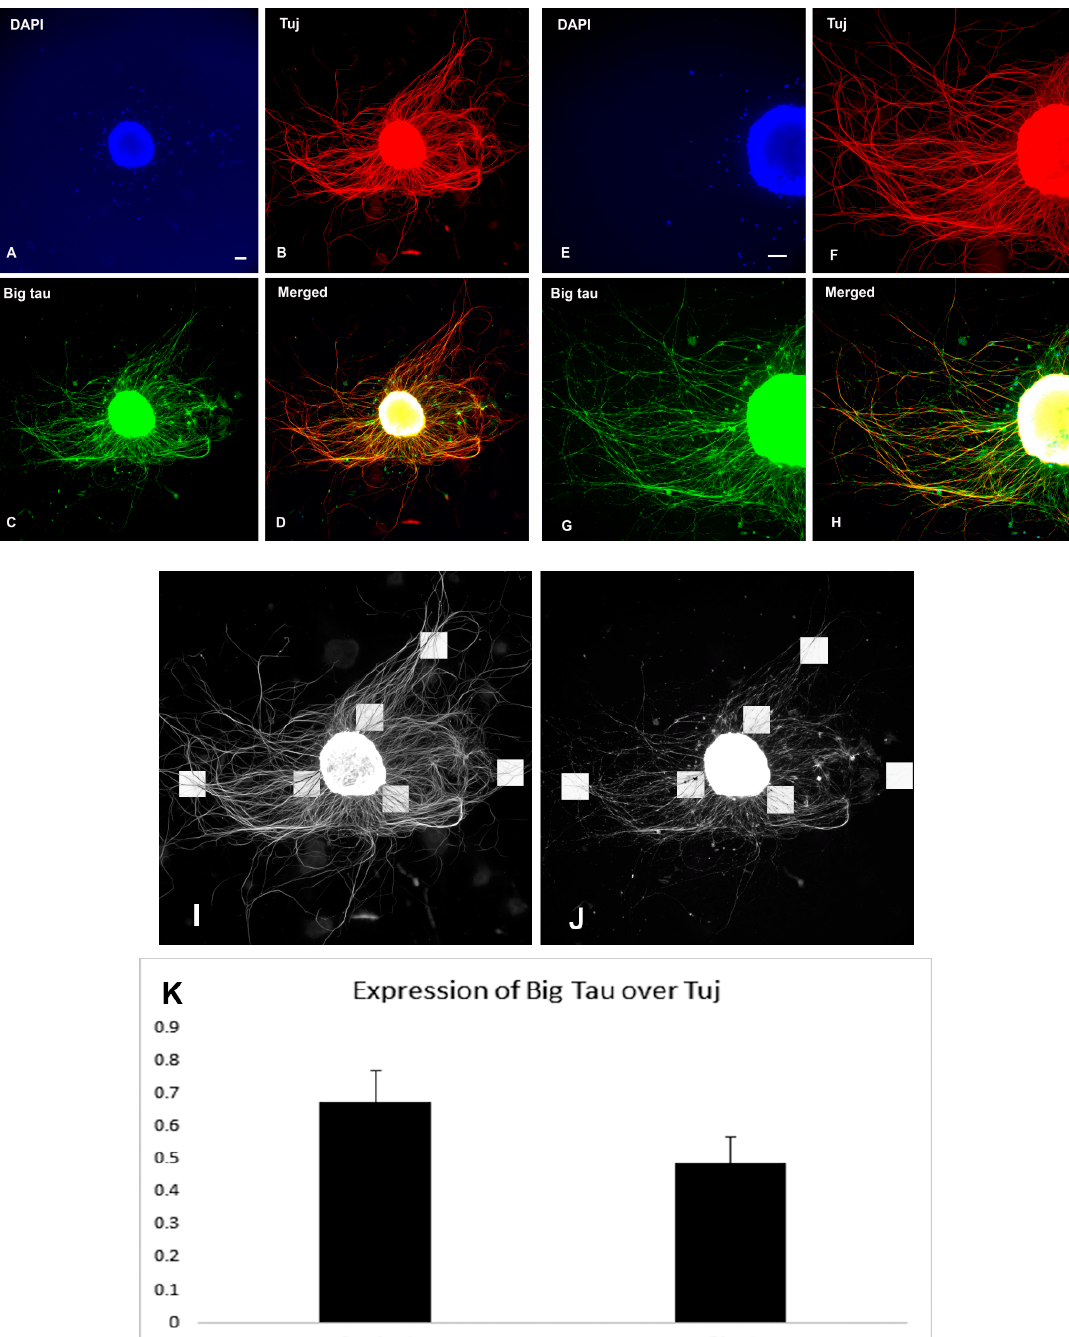
Figure 10. Big tau expression after SCG explant lesion (5 days). P3 SCG explants were cultured for 8 days and then continued to grow for 5 days after lesion. Panels ( A – D ) show SCG explant with lesion at low magnification. Panels ( E – H ) show SCG neurites growing at the high magnification. The DAPI staining show the explant cell bodies ( A , E ), while Tuj ( B , F ) and Big tau ( C , G ) antibodies also stain the regrowing neurites (merged in ( D , H )). Note that at 5 days post-lesion Big tau is expressed along the entire length of the neurites similar to the staining of Tuj. The analysis of the ratio of Big tau/Tuj 5 days after lesion is based on data on presented in ( B , C ). Panels ( I , J ) indicate the proximal and distal locations ( n = 3) of the areas included in average density calculation, respectively, expressed as a ratio of Big Tau over Tuj ( K ). There is no significant difference between the ratios of Big tau/Tuj densities at proximal explant relative to distal ( p = 0.22). Scale bar = 100 μ m.